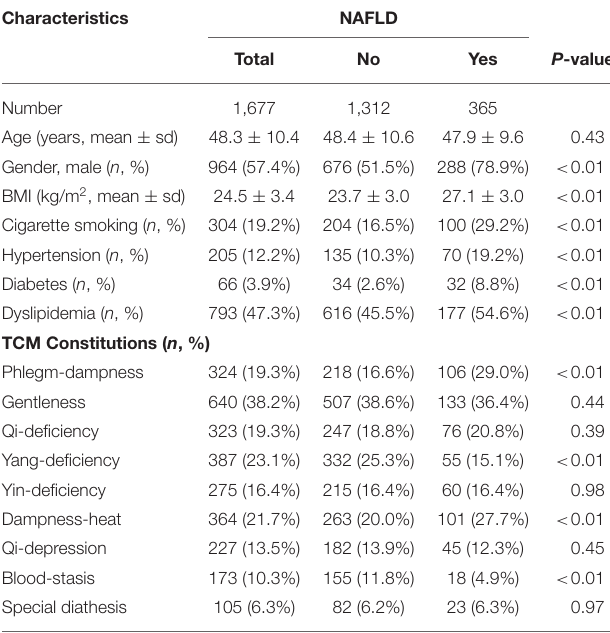
TABLE 1 | Baseline characteristics of 1,677 participants according to non-alcoholic fatty liver disease status.